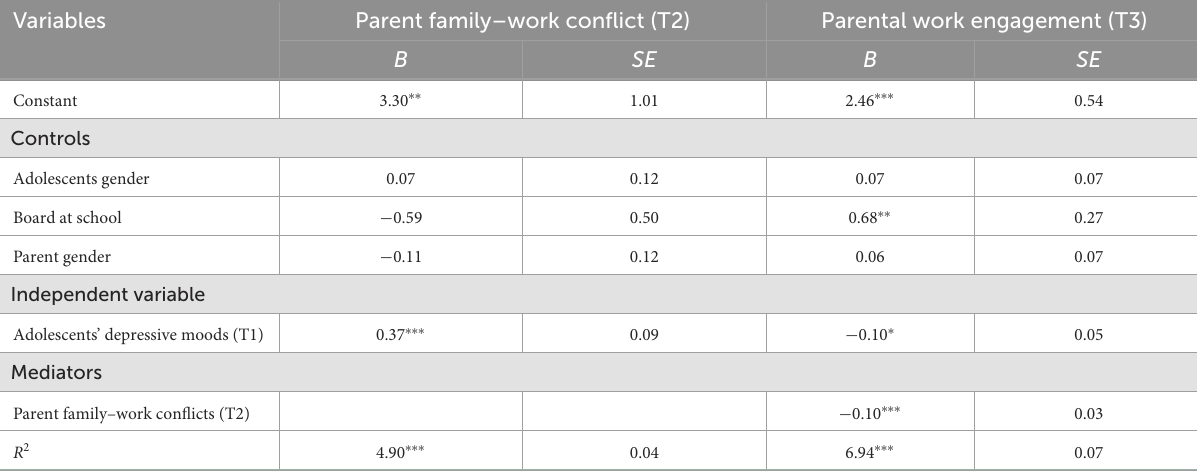
TABLE 3 Summary of regression analysis results of hypothesis 1.